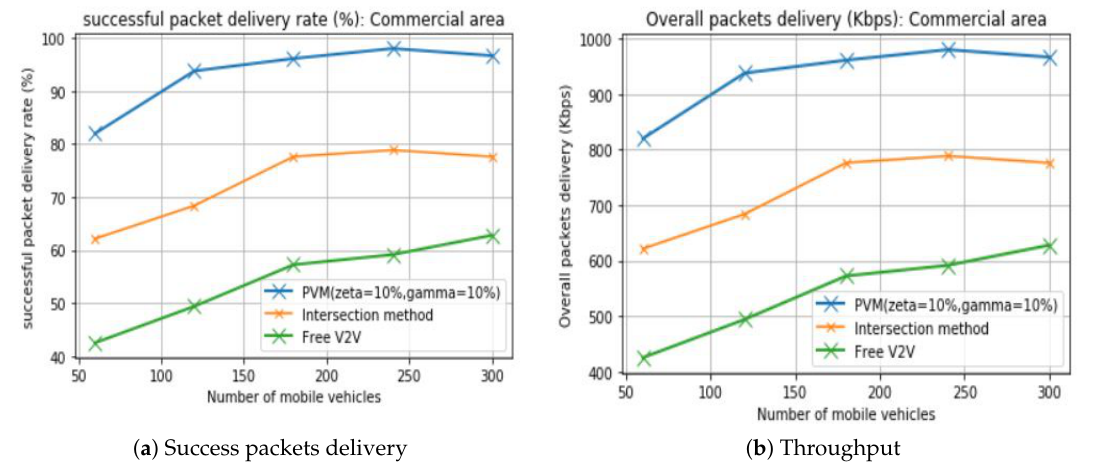
Figure 24. Success Packets delivery & Throughput: Commercial